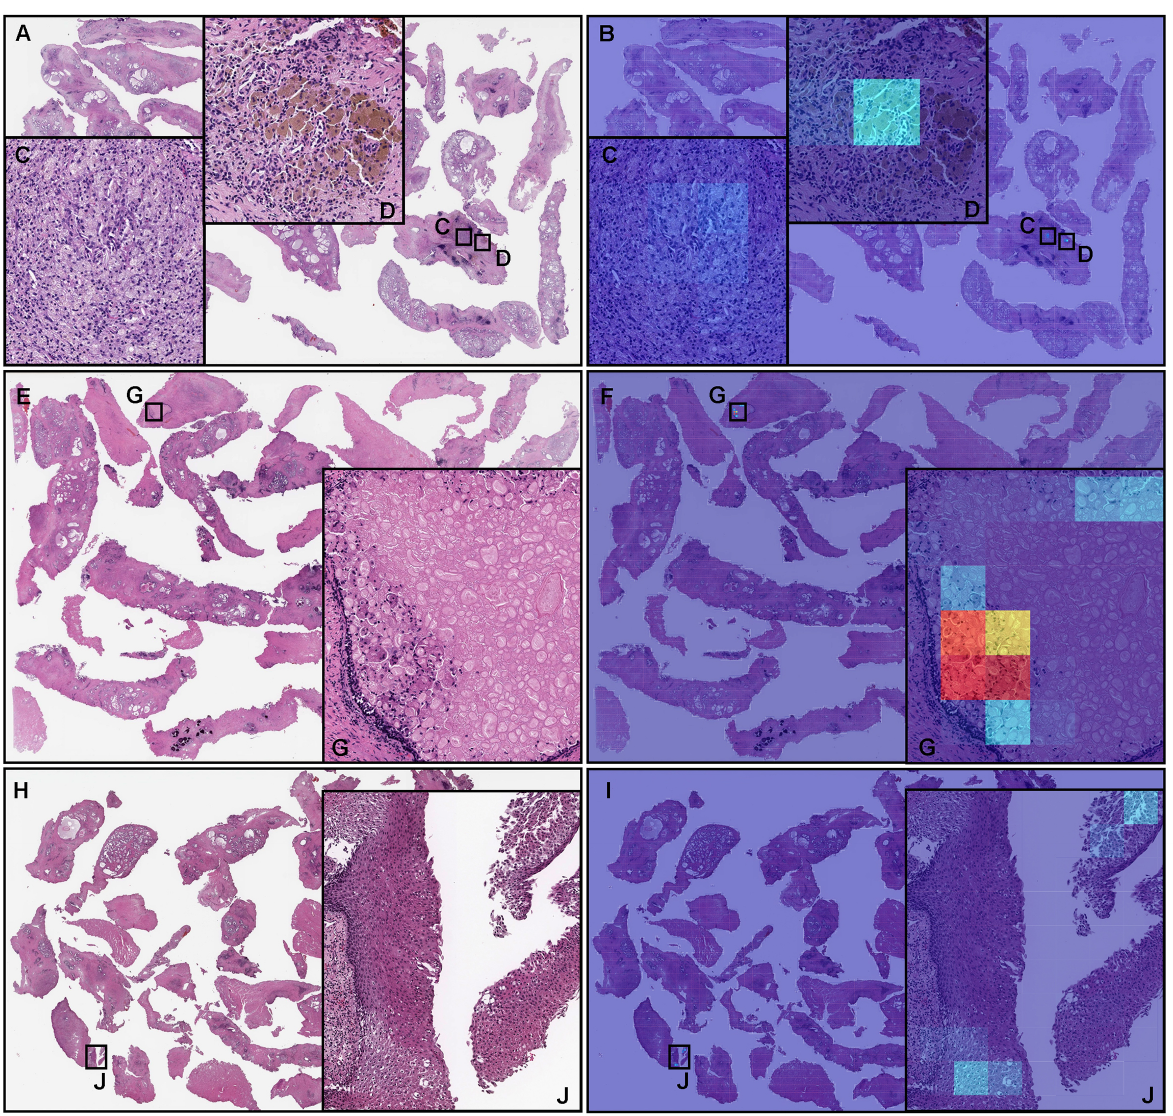
Figure 7. Representative examples of prostate adenocarcinoma false positive prediction outputs on whole-slide images (WSIs) from the transurethral resection of the prostate (TUR-P) test sets using the model (TL-colon poorly ADC-2 ( × 20, 512)). Histopathologically, ( A , E , H ) have no evidence of adenocarcinoma infiltration. The heatmap images ( B , F , I ) exhibit false positive predictions of prostate adenocarcinoma ( C , D , G , J ) where the tissues consist of xanthogranulomatous inflammation ( C , D ), macrophagic infiltration ( G ), and squamous metaplasia with pseudo-koilocytosis ( J ), which are most likely the primary cause of the false positive prediction due to its morphological similarity to prostate adenocarcinoma cells. The heatmap uses the jet color map where blue indicates low probability and red indicates high